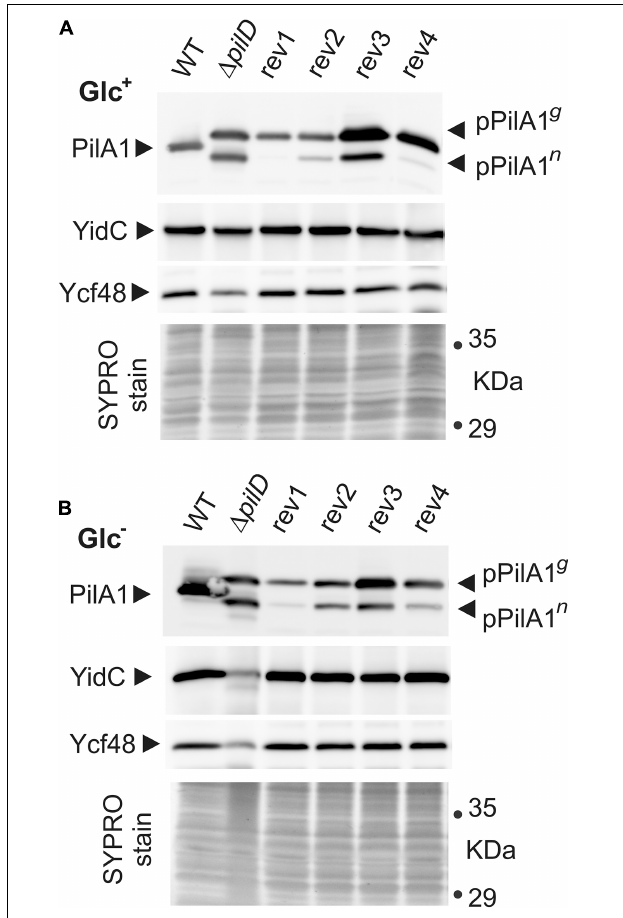
FIGURE 5 | Cellular levels of pPilA1 g and pPilA1 n proteins and the stability of YidC and Ycf48 in the WT, (cid:49) pilD mutant, and (cid:49) pilD revertant strains. Membrane proteins were isolated from Glc + (A) and Glc − conditions (B) , separated by SDS-PAGE and blotted; the loading corresponded to the same number of cells based on OD 730 . Pilin and prepilin forms of PilA1, YidC insertase, and Ycf48 were immunodetected by specific antibodies. The gel stained with SYPRO Orange before blotting is shown below the blot as a loading control. pPilA1 g , pPilA1 n designate glycosylated and non-glycosylated prepilins,